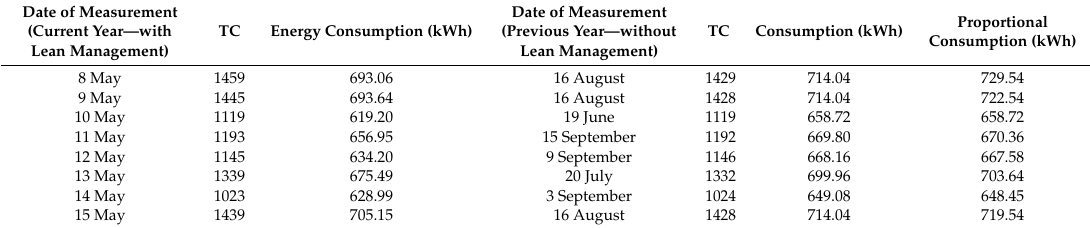
Table 10. Comparison of energy consumption during the day with the old and new schedule. Date of Measurement (Current